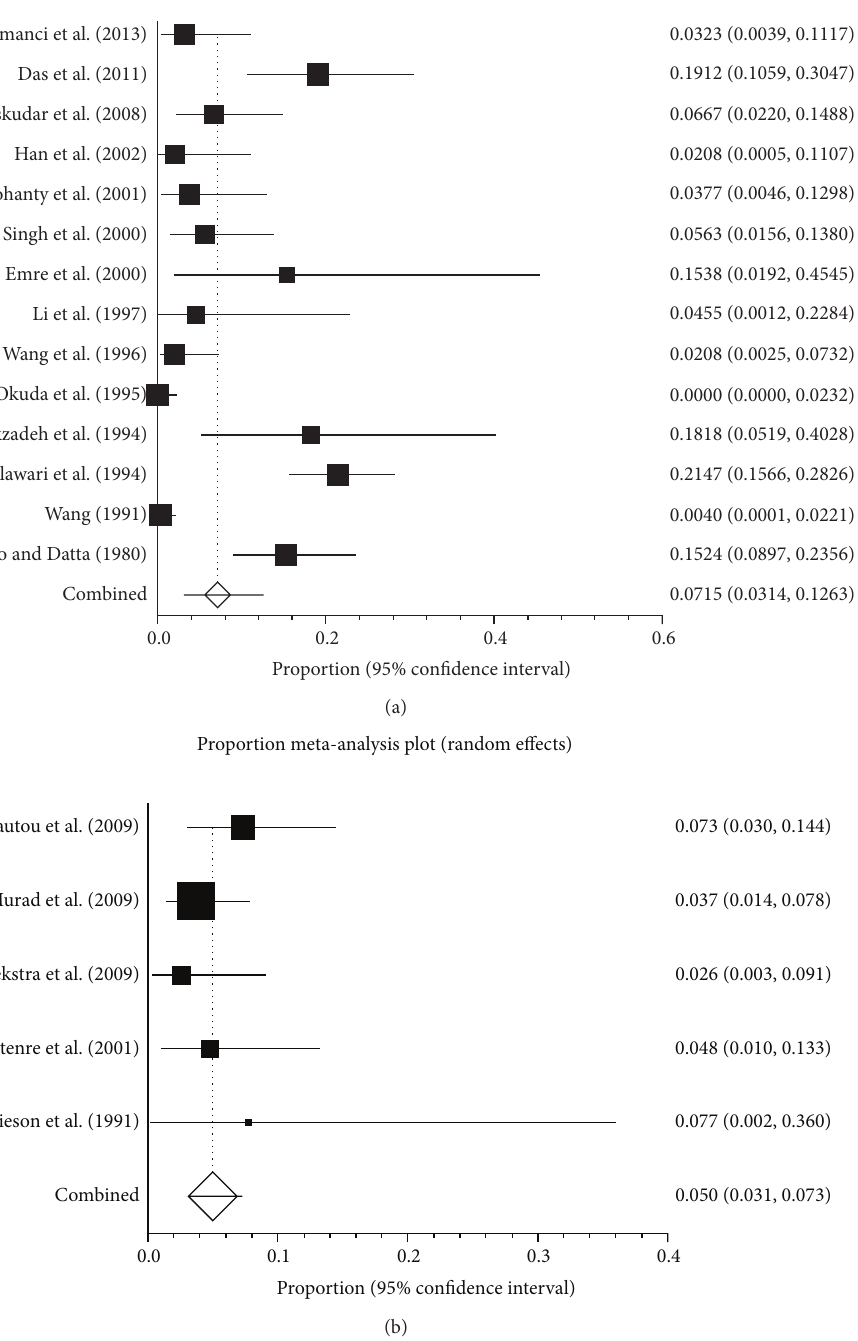
systematic review and meta-analysis to evaluate the preva- lence of BCS during pregnancy or puerperium. An